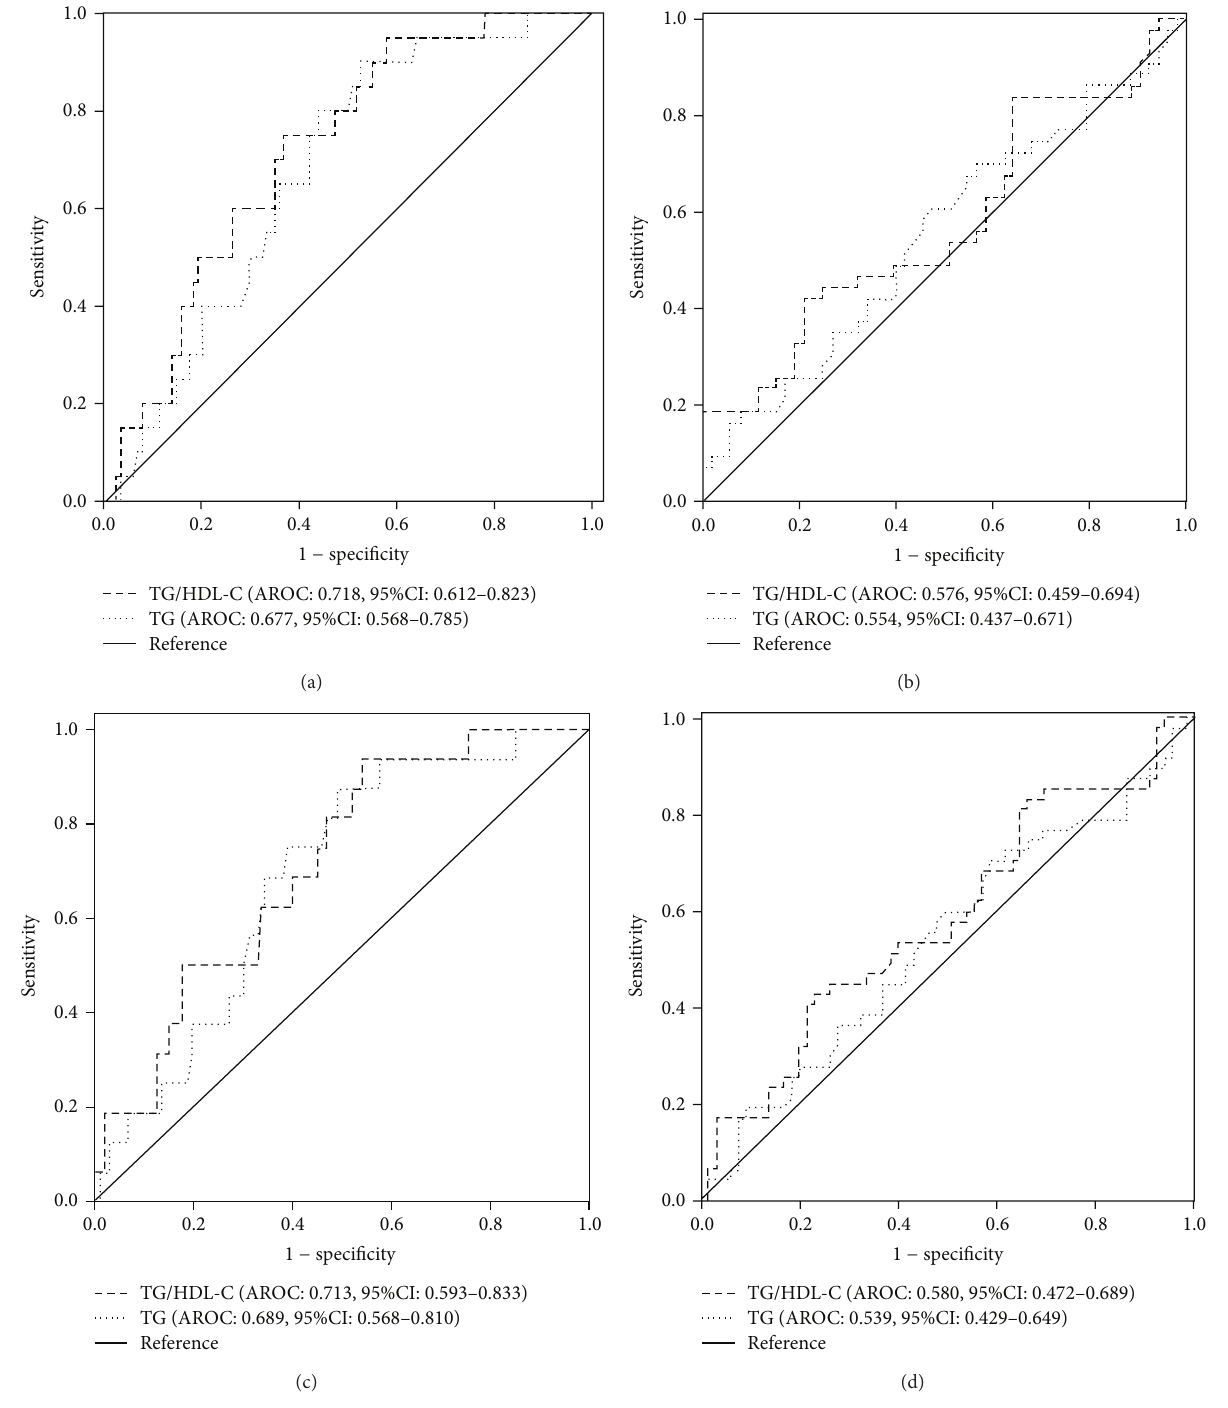
Figure 1: Area under the receiver operating characteristic curves of TG and TG/HDL-C for discriminating insulin resistance in women. AROCs of TG and TG/HDL-C for predicting insulin resistance in women with a BMI < 24kg/m 2 ((a), 𝑛 = 134 ) and in women with a BMI ≥ 24 kg/m 2 ((b), 𝑛 = 118 ). AROCs of TG and TG/HDL-C for predicting insulin resistance in women with a waist circumference < 80 cm ((c), 𝑛 = 96 ) and in women with a waist circumference ≥ 80cm ((d), 𝑛 = 112